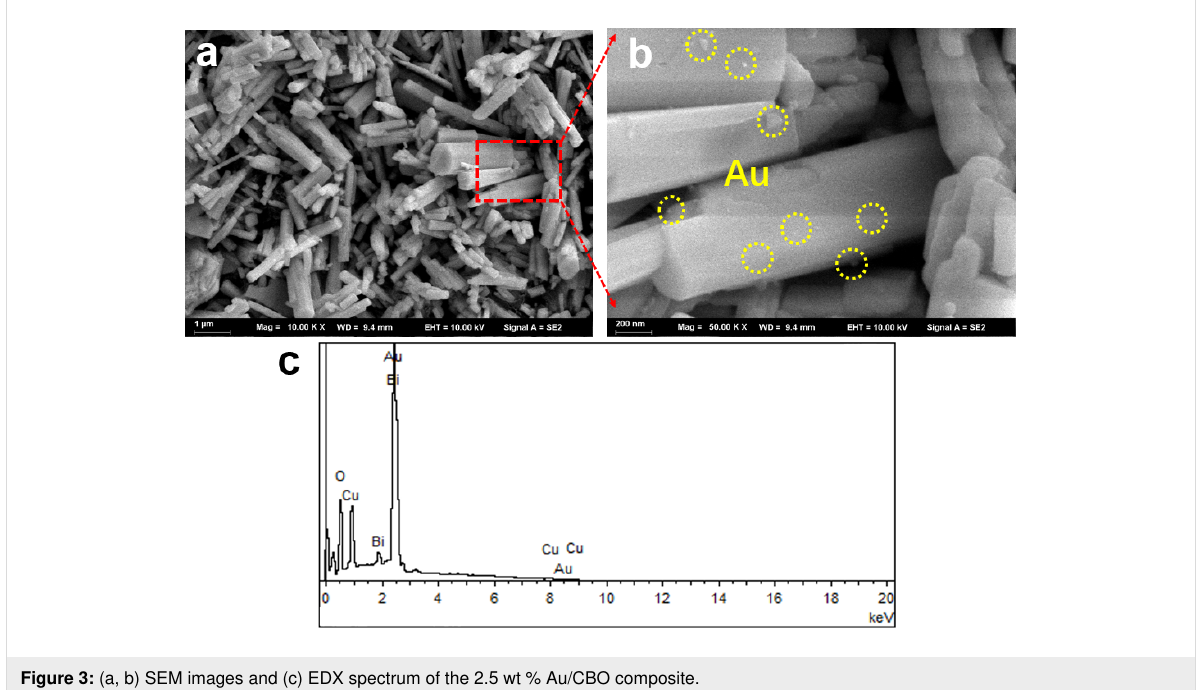
Figure 3: (a, b) SEM images and (c) EDX spectrum of the 2.5 wt % Au/CBO composite.